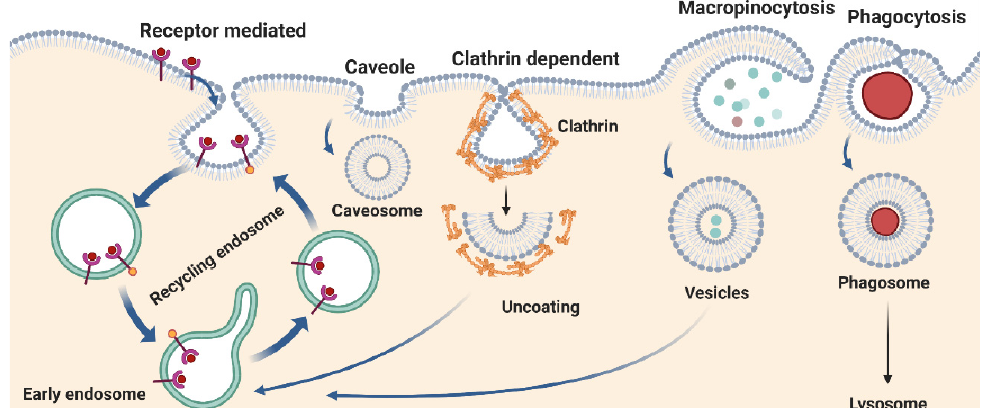
Figure 1. Different pathways of endocytosis. Endocytosis can be broadly classified into pinocytosis and phagocytosis. Pinocytosis involves the internalization of small molecules, whereas phagocytosis involves the internalization of large particles like microbes. Receptor mediated endocytosis is a selec- tive mechanism and the complex proteins recycled to cell membrane. Caveolin encapsulates trans- ported molecules in the caveosomes and protects against lysosomal degradation. Clathrin-mediated endocytosis (CME) requires grafting of specific sorting sequences into membrane downturns and re- cruits clathrin moieties for cargo internalization.